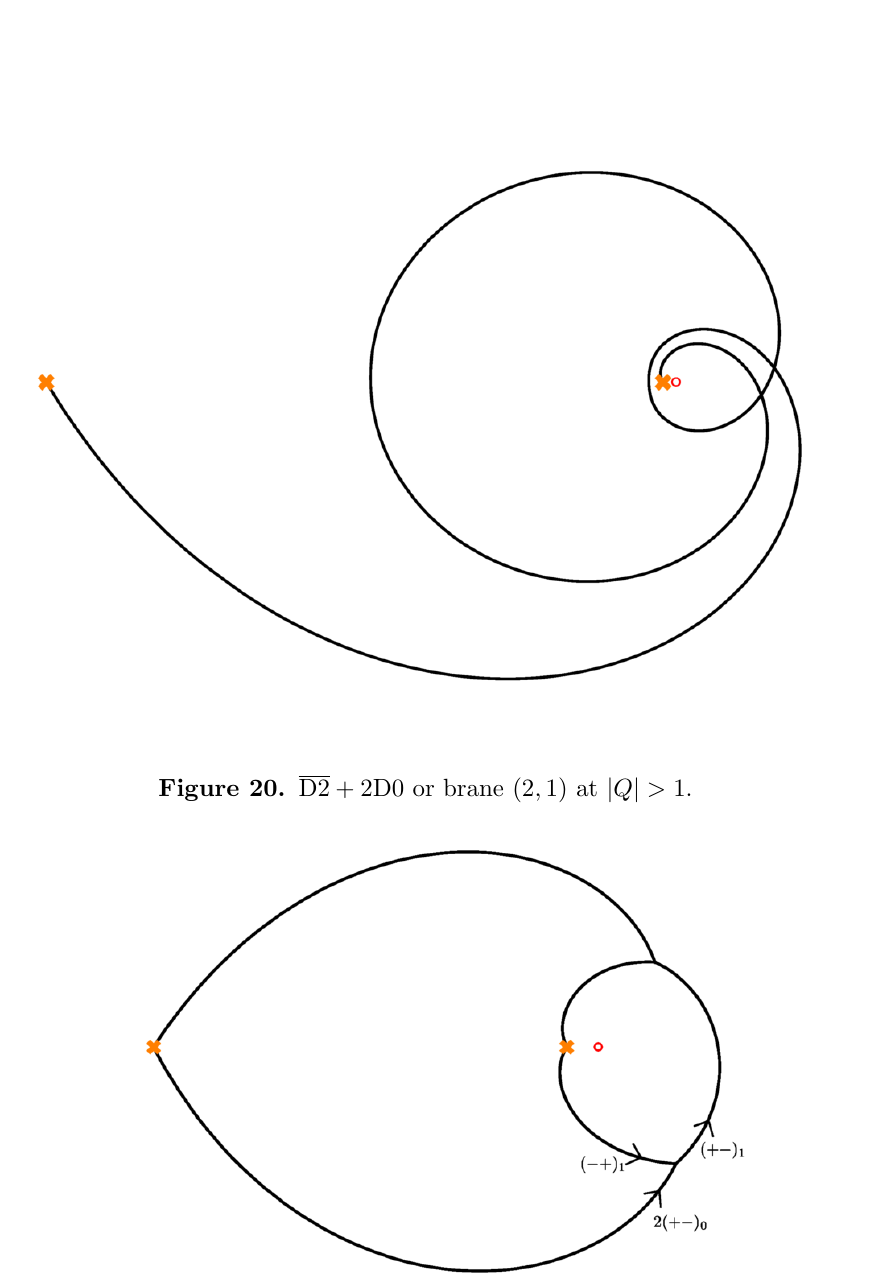
Figure 21. Brane (2 ; 1) at j Q j < 1.